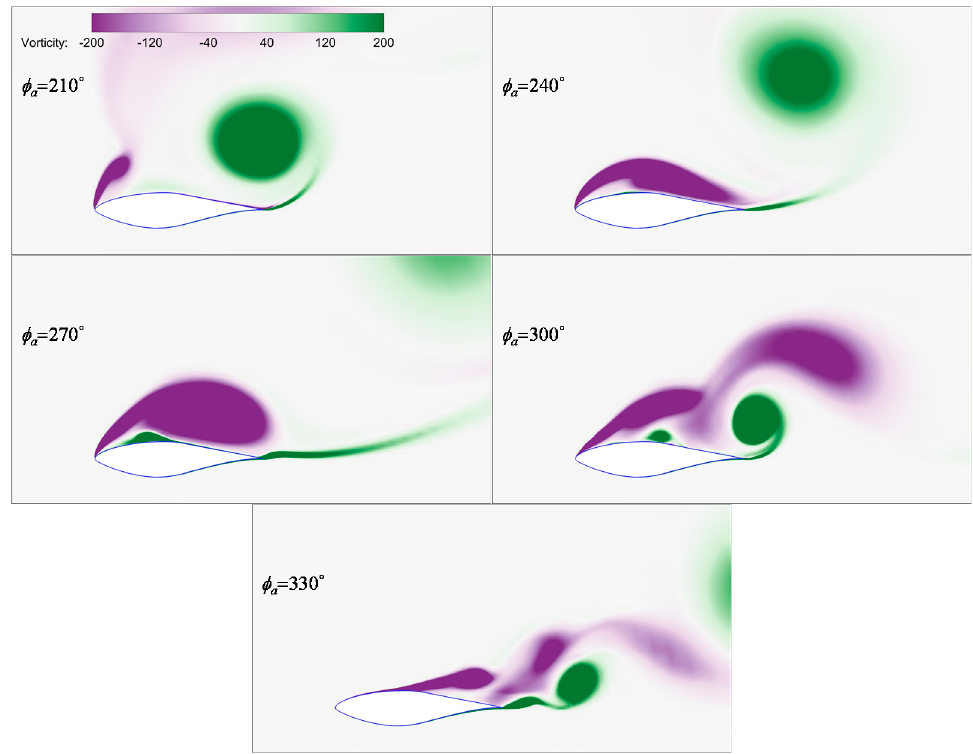
Figure 15. Development of the vorticity field around the 2D airfoil from ϕ a = 210° to ϕ a = 330°.